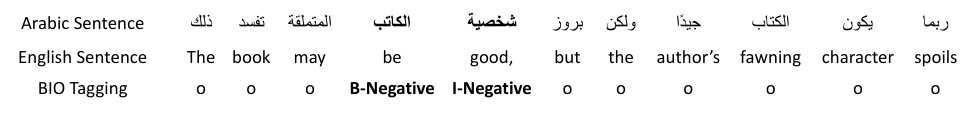
Figure 3. First type of error: long and complex structure of some aspect terms. First example.